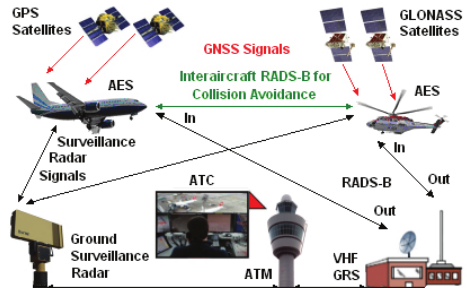
Figure 3. Aeronautical RADS-B Network – Courtesy of Manual: by Ilcev